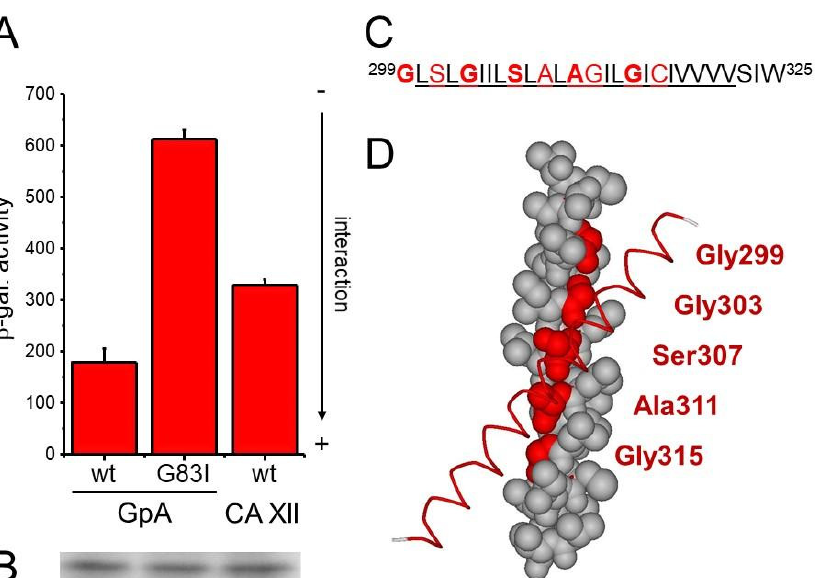
Figure 1. Human CA XII TM helix–helix interaction. ( A ) When measured with the GALLEX assay, the wild-type CA XII TM domain has a significant interaction propensity compared to the strongly interacting TM domain of human GpA and the weakly interacting GpA variant G83I. The interaction propensities are an average of three independent measurements and the standard deviation is shown. ( B ) Identical amounts of isolated total membrane proteins of cells analyzed in ( A ) were separated in an SDS gel, and the expressed amount of the Ca XII TM fusion protein was tested via Western blot analyses using an antibody directed against the MalE protein. All analyzed proteins were expressed at similar levels. ( C ) Sequence of the human CA XII TM region. The TM regions as predicted by TMHMM are underlined. Small residues are highlighted in red. Small residues at a distance of four are highlighted in bold. ( D ) Model of the human CA XII TM domain dimer predicted by the PREDDIMER server. CPK representation of one TM domain with highlighted and labeled small residues Gly299, Gly303, Ser307, Gly311, and Gly315. The interacting helix is shown as a C α wire.